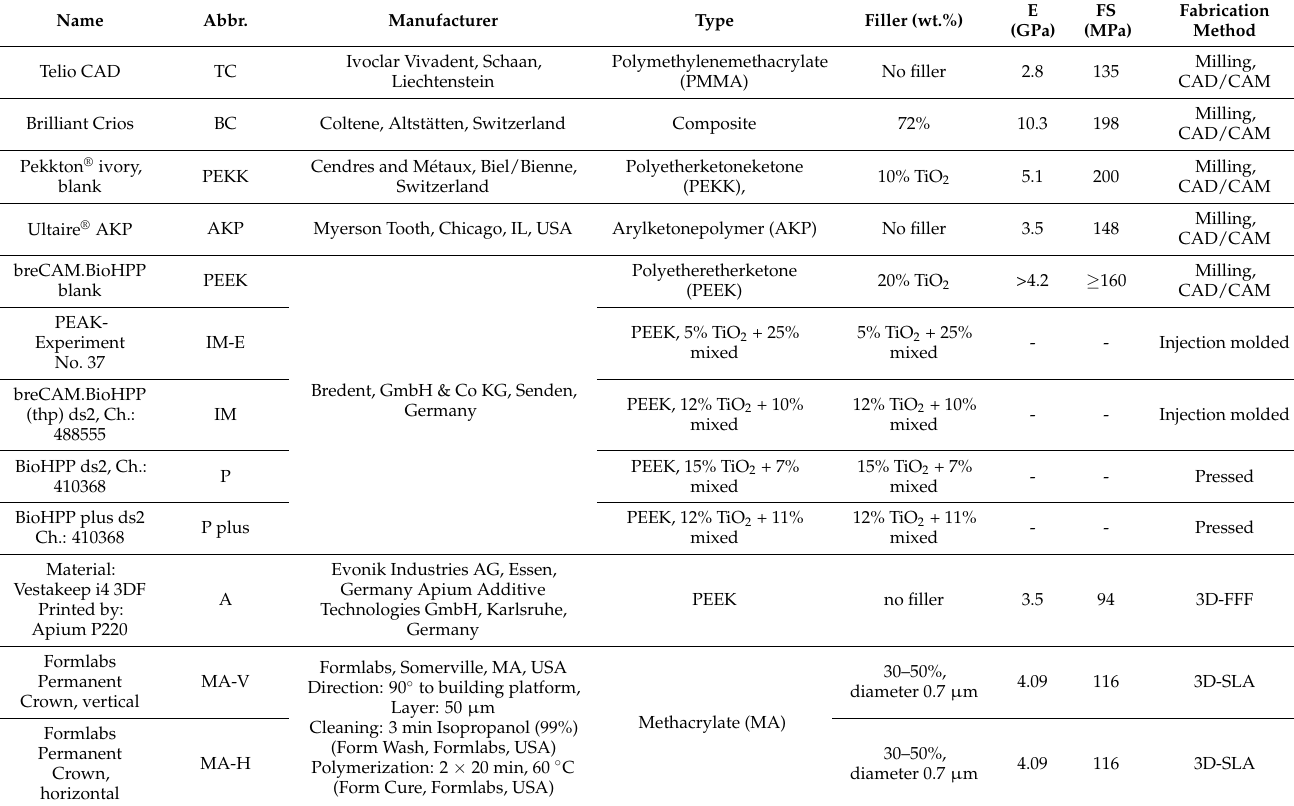
Table 1. Name, abbreviation, manufacturer, type, composition, mechanical properties, and fabrication method of materials (-: no values available, PEEK: